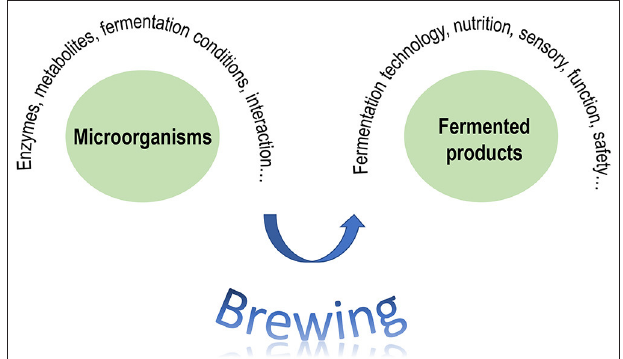
FIGURE 1 | The main research aspects on food